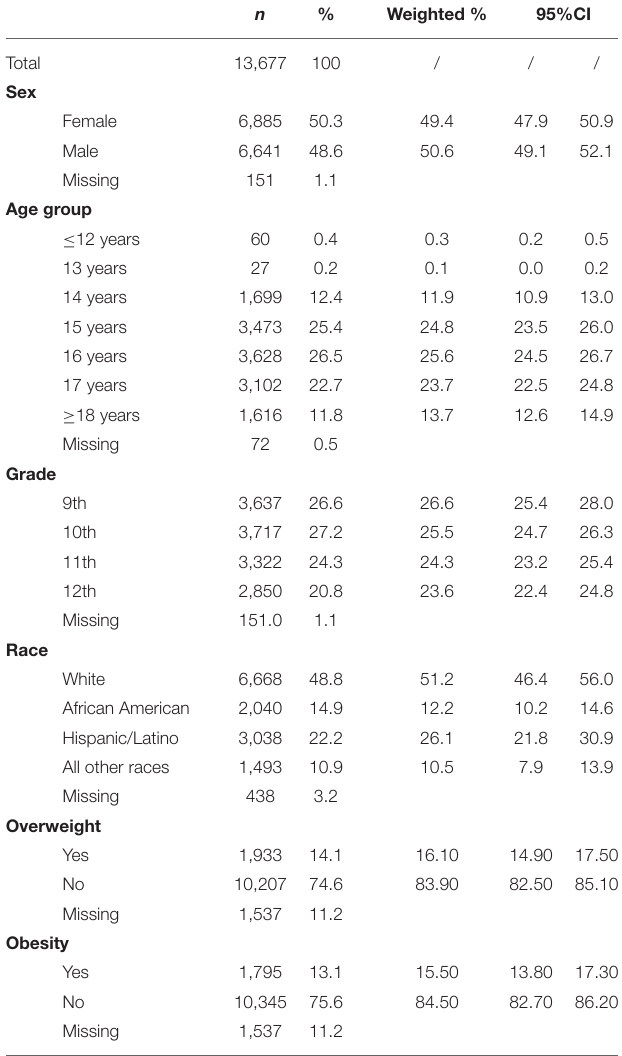
TABLE 1 | Demographic characteristics of the